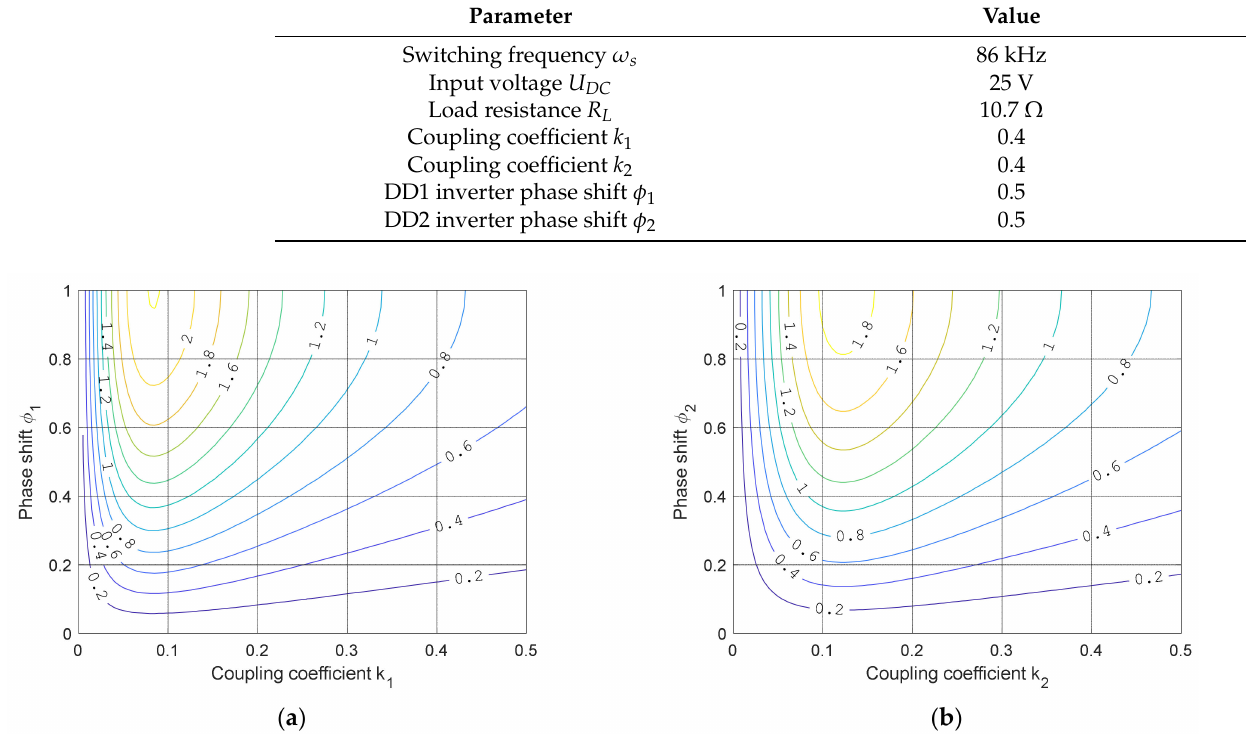
Figure 7. Gain of the IPT converter under different operating conditions. ( a ) DD1 part of the IPT system, ( b ) DD2 part of the IPT system.